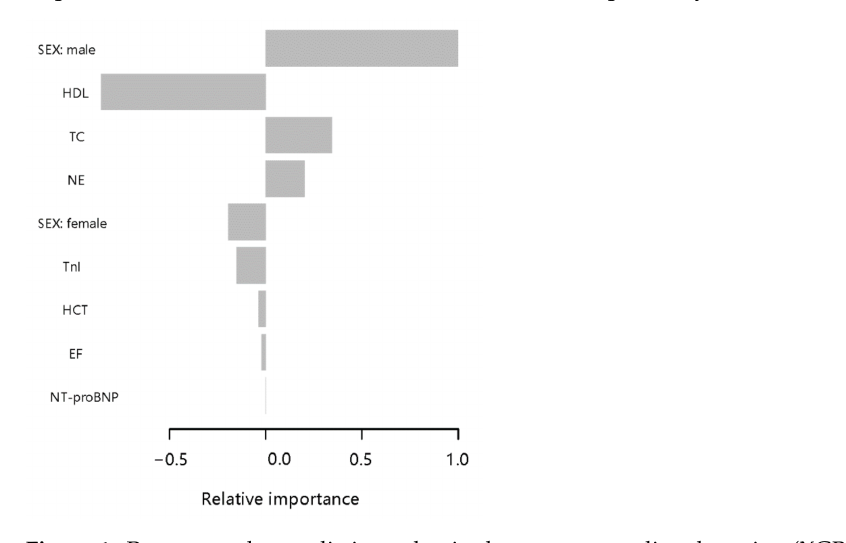
Figure 1. Parameters by predictive value in the extreme gradient boosting (XGBoost) model. To predict CTO, gradient boosting used various variables based on their importance in prediction modeling. In this analysis, the sex and HDL had higher values in the prediction of CTO than other features of